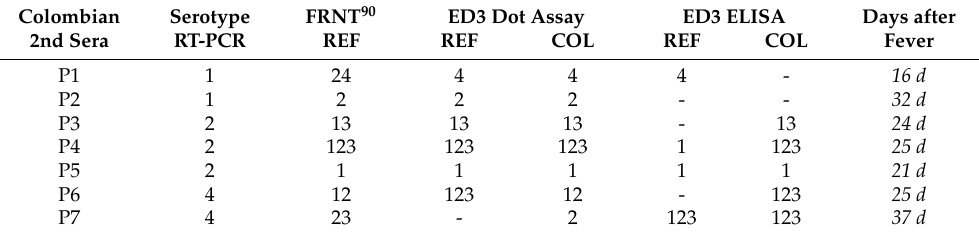
Table 6. Serotype specificity of antibodies in Colombian second sera P1 − P7.